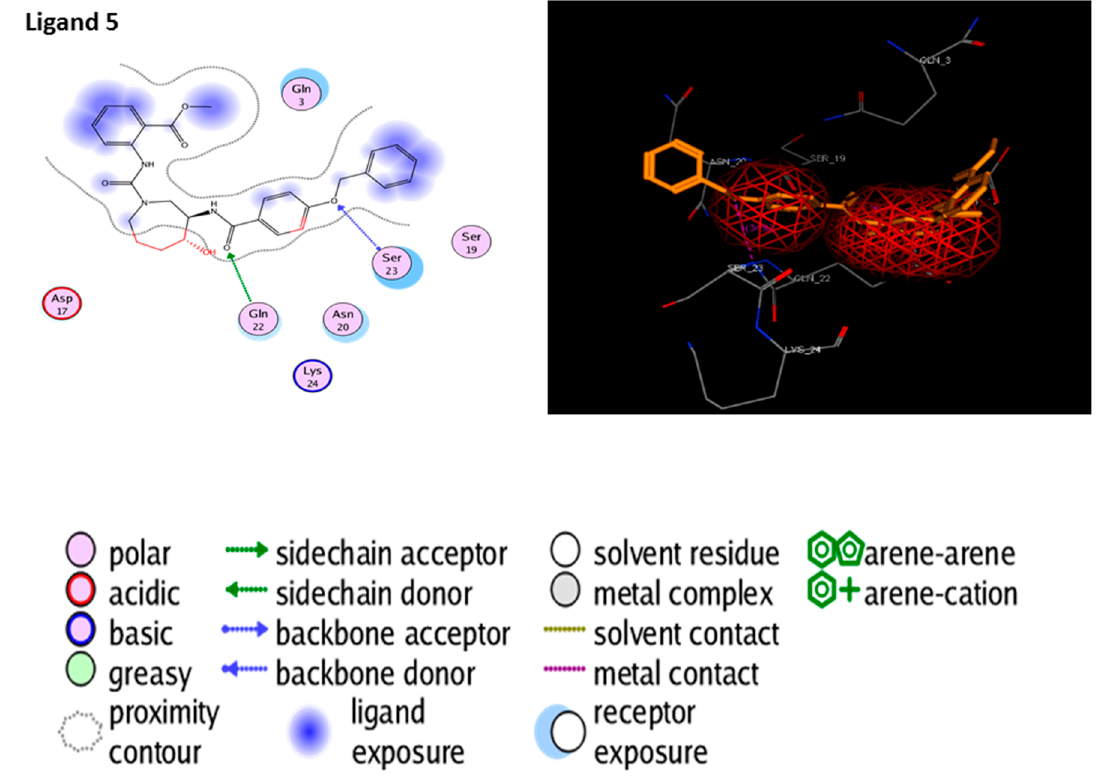
Figure 8. 1D-3D ligand interaction diagrams for the top five ligand molecular poses of docking protein- ligand interaction analysis in MOE, along with docking key legends.